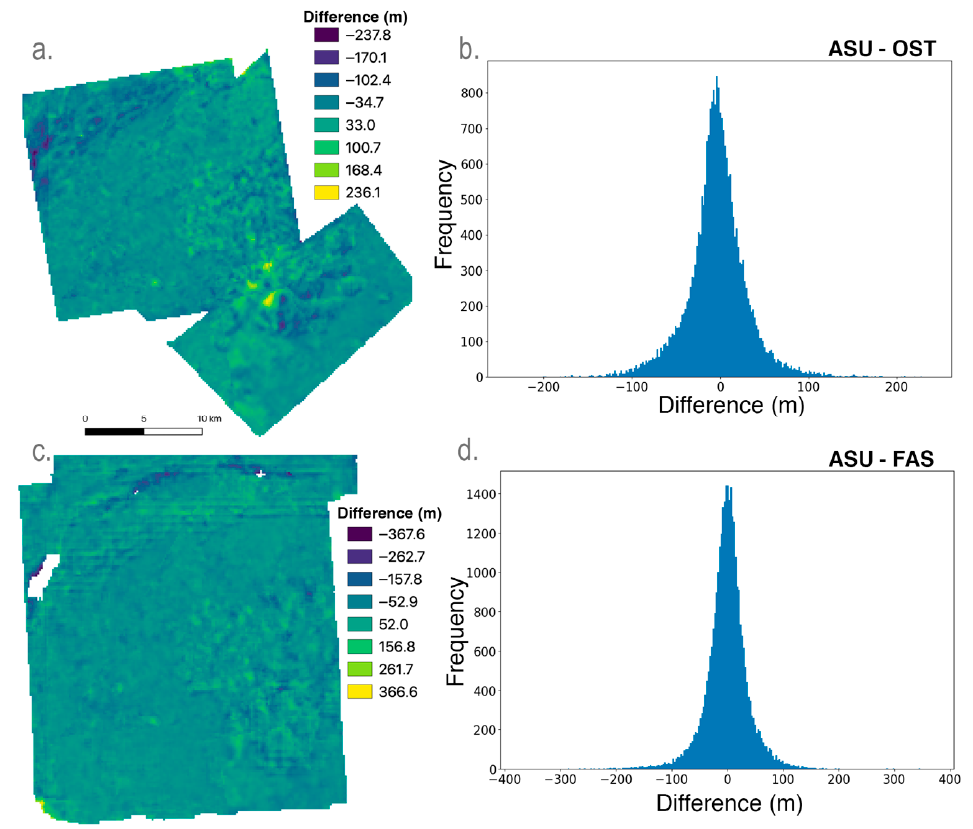
Figure 10. ( a , c ) Difference maps of Sander crater: OST and FAS DEMs subtracted from ASU DEM. ( b , d ) Histograms of the difference values.